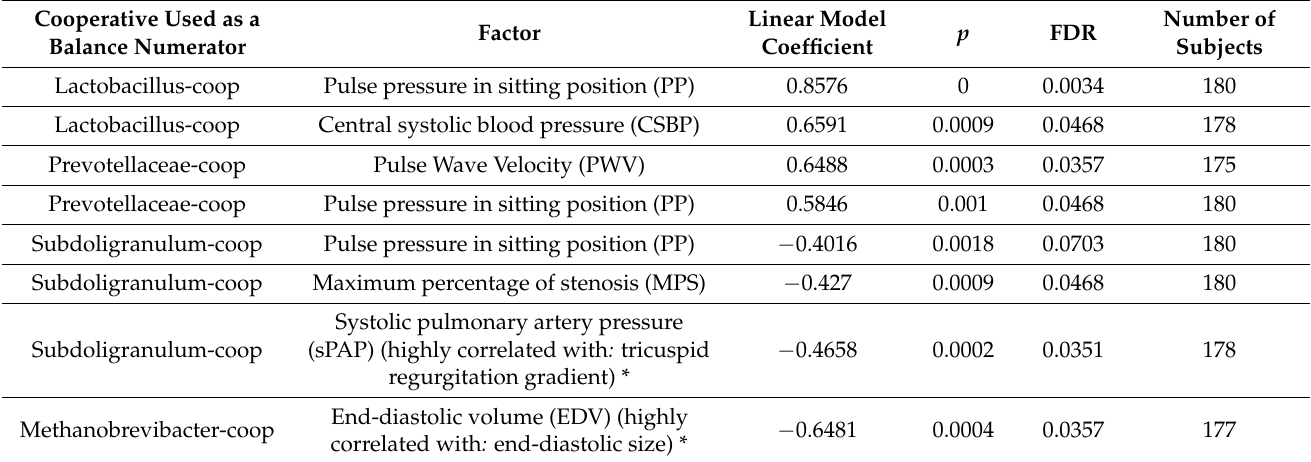
Figure 3. Associations between clinical cardiovascular markers and genera cooperatives. Significant correlations and associations are shown with solid and dashed lines, respectively. Red lines denote positive associations and blue lines denote negative associations. The width of the solid lines is proportional to the Spearman correlation coefficient between cardiovascular markers (ranging from 0.17 to 0.54). The size of nodes corresponding to markers is proportional to the minimal p value of the associations between the marker and cooperatives. The size of the nodes corresponding to genera is proportional to their mean abundance in the dataset. Table 2. Cardiovascular markers significantly linked to gut microbiome composition at the level of bacterial cooperatives. Samples are pooled across the groups.